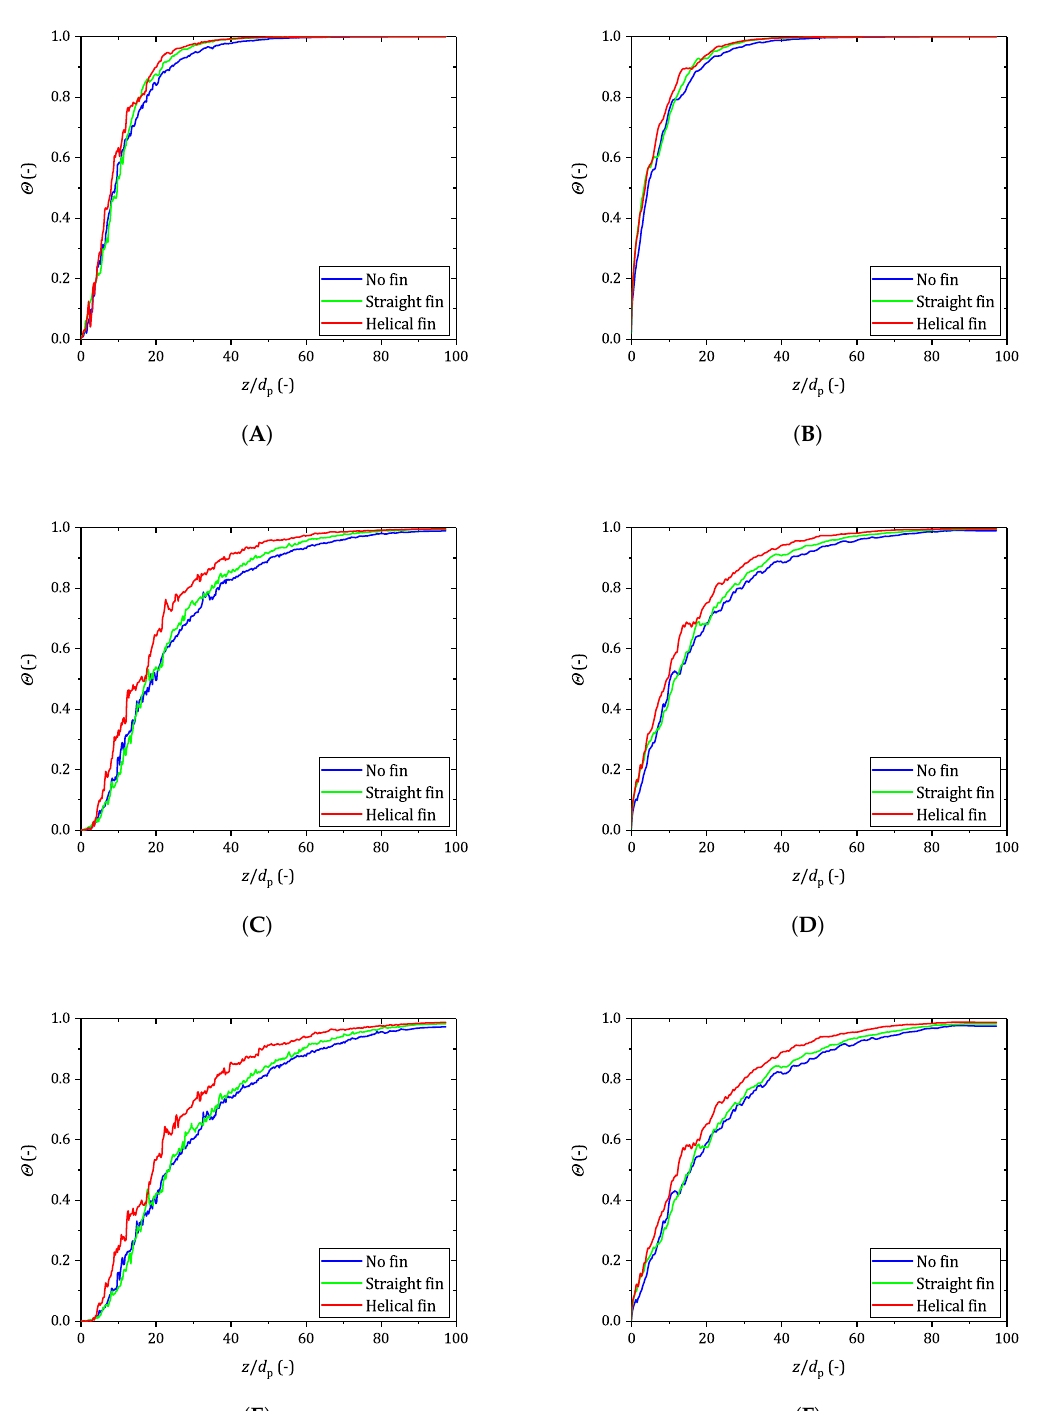
Figure 12. Comparison of the axial profile of the core temperature ( left ) and the averaged temperature ( right ) for Re p = 105.6 ( A , B ), Re p = 528 ( C , D ) and Re p = 1056 ( E , F